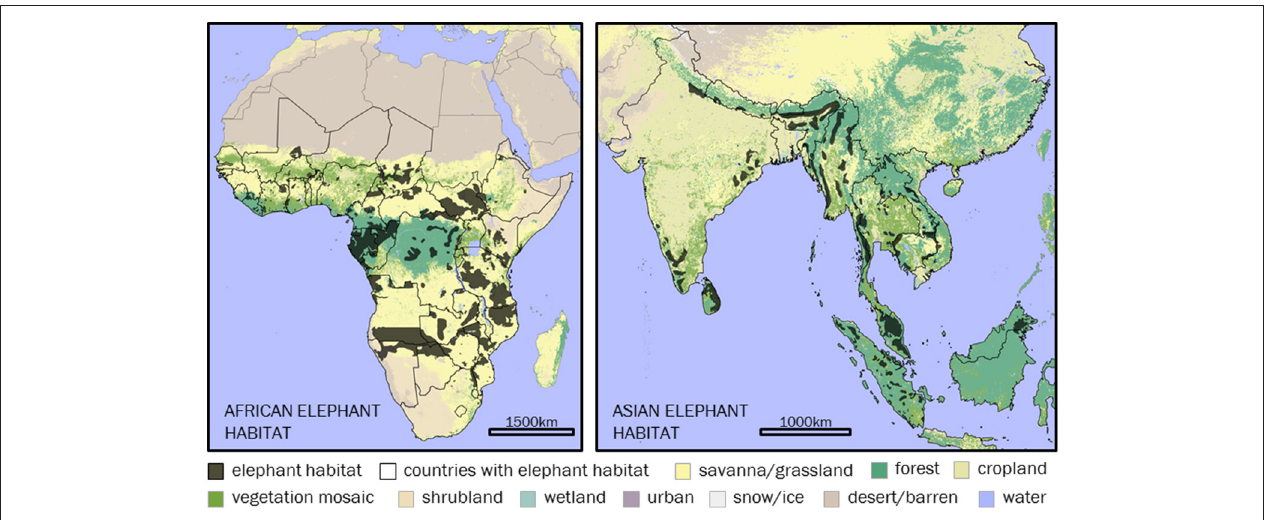
FIGURE 1 | Map of global elephant species ranges. Land cover based on mode value of 500-m resolution NASA MODIS Land Cover Type product (MCD12Q1), 2000–2016. (Elephant population data from Friedl et al., 2010; IUCN,